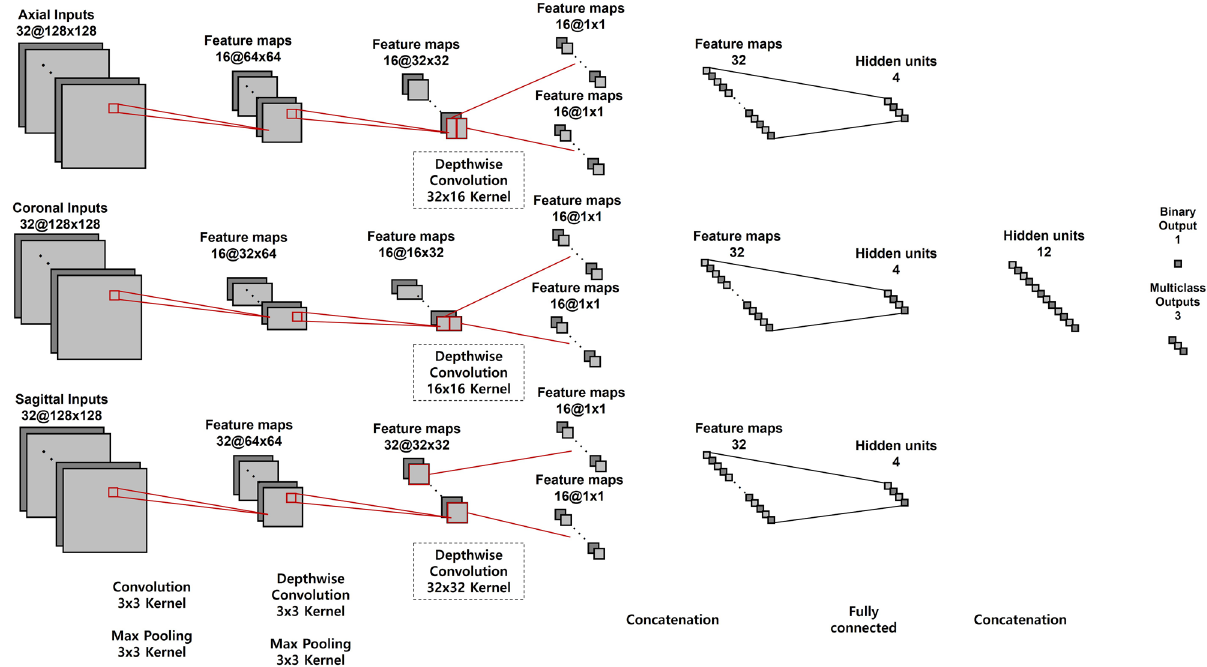
Figure 5. The schematic block diagram of the proposed NN. The size of feature maps and the types of operations for each layer are described sequentially according to the data